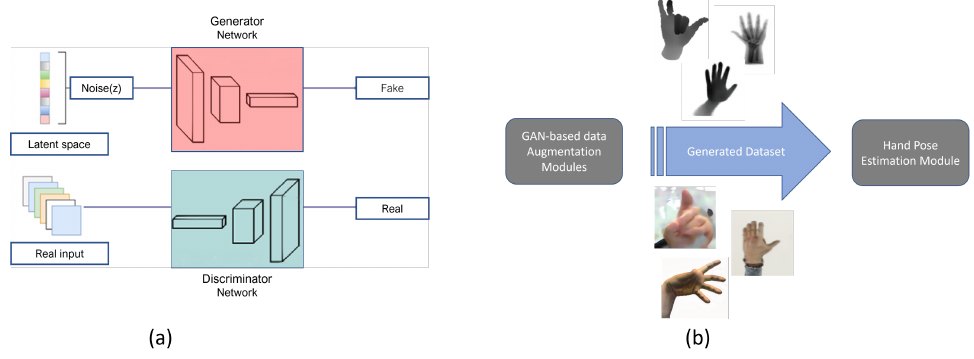
Figure 1. GAN-based hand pose data augmentation. ( a ) Overview on generative adversarial network, ( b ) procedure illustration of using generated data in HPE